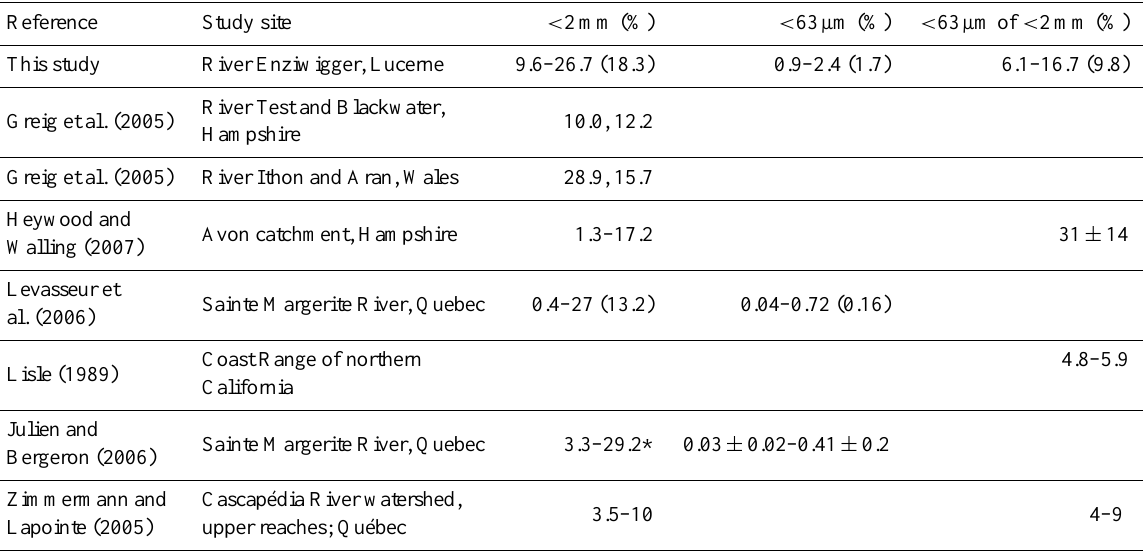
Table 6. Fine sediment ( < 2mm) and silt and clay ( < 63µm) accumulation in the accumulation baskets as % of the whole baskets and the silt and clay fraction of the sediment < 2mm. Range (mean) or mean ± standard